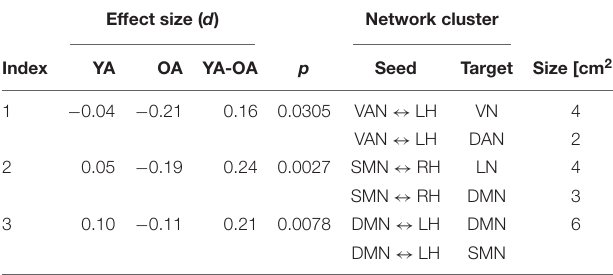
TABLE 3 | FCs quantified by effect sizes (Cohen’s d ) for YAs and OAs.